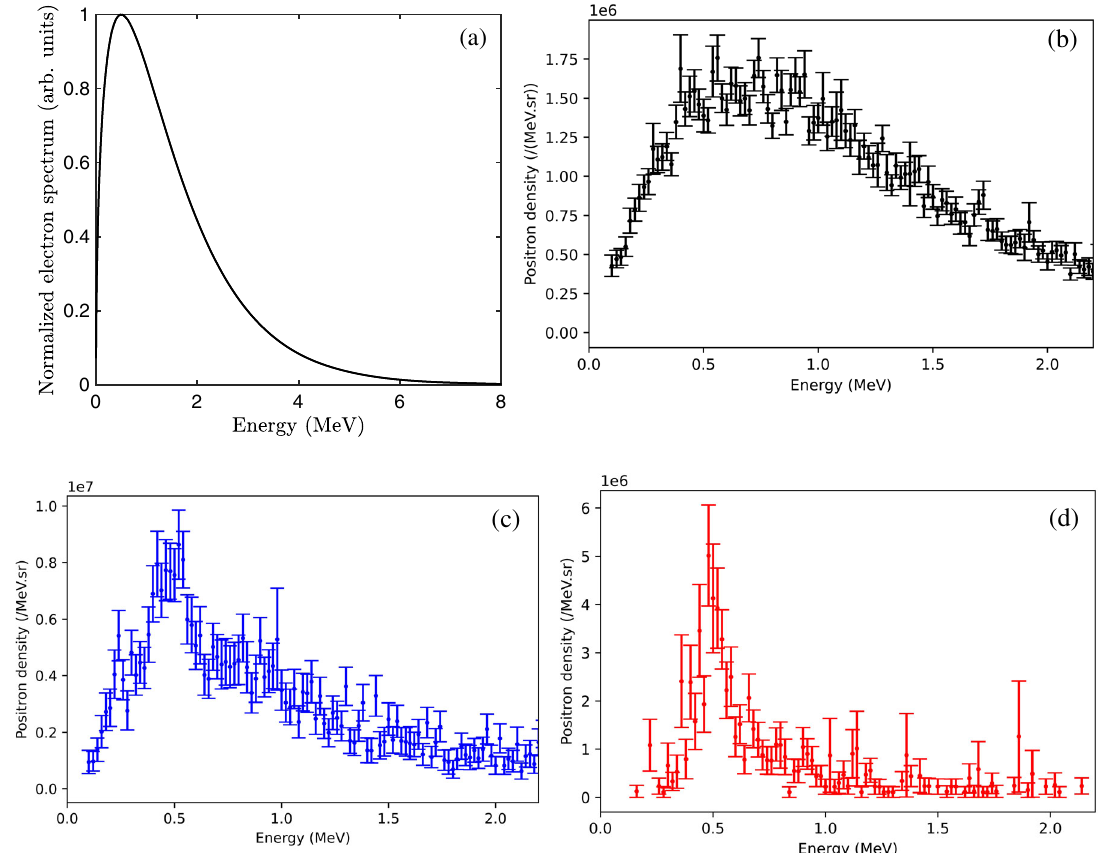
FIG. 6. (a) Normalized electron energy distribution used as input for FLUKA simulations. Positron spectra obtained with FLUKA in: (b) the generation only configuration without quadrupoles or second dipole; (c) in the collimation only with quadrupoles but no second dipole; and (d) using the full system.